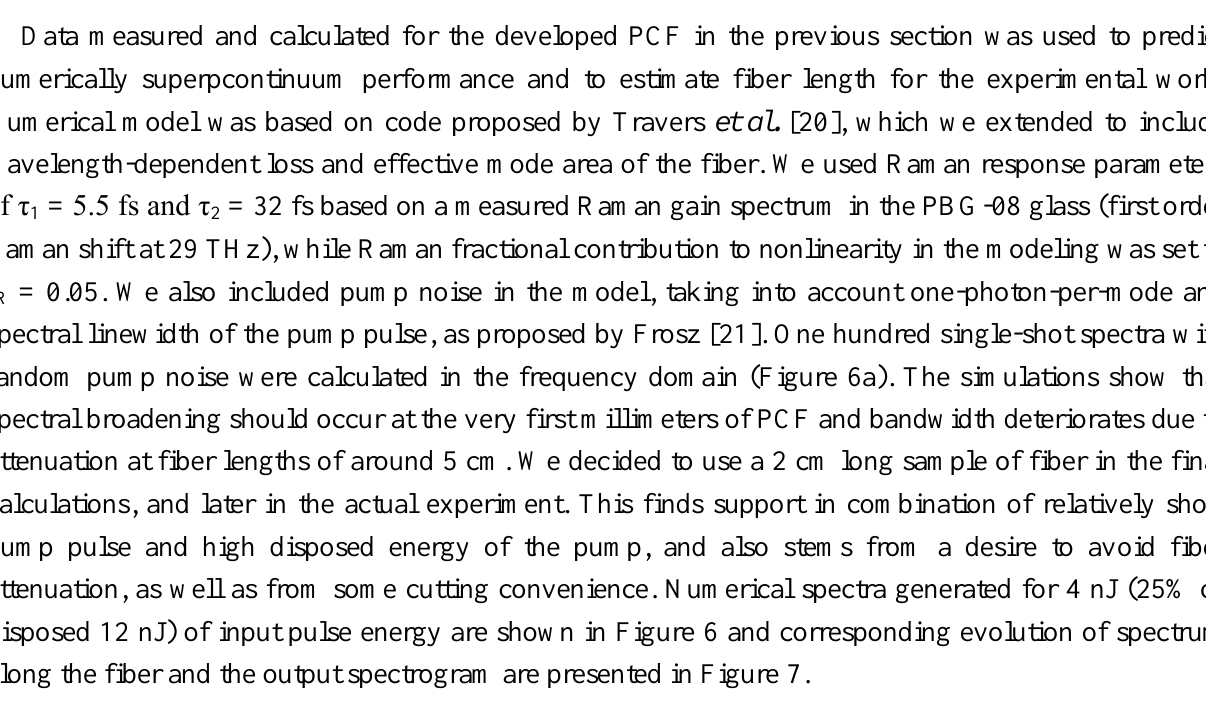
Figure 6. ( a ) Numerically generated supercontinuum spectrum (solid line, average over 100 shots) with numerically generated full range of intensity fluctuations (faded background); ( b ) FWM phase-matching curves calculated for 4 nJ of launched pump energy.